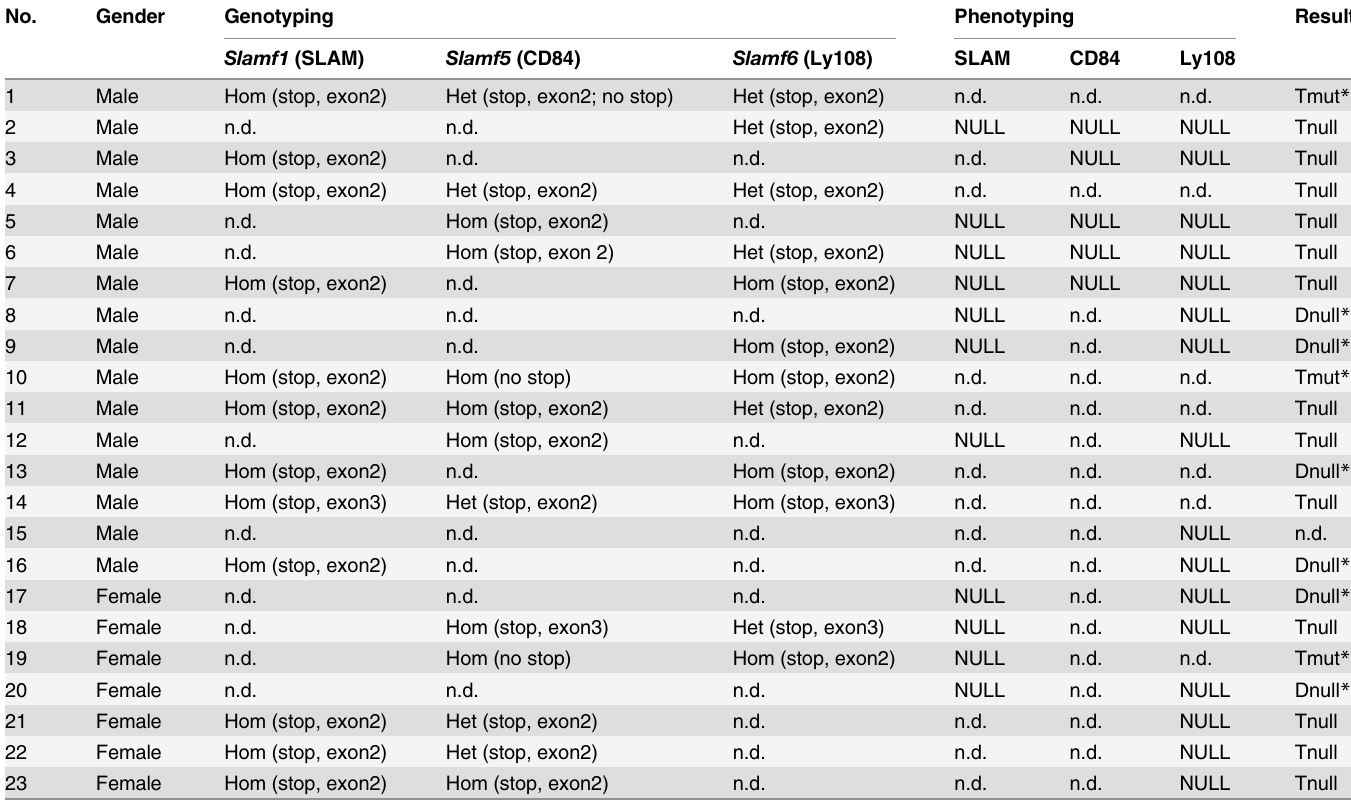
Table of mouse genotyping and phenotyping showing a high ef fi ciency of genetic mutation resulting in mice de fi cient in the expression of multiple SLAM family receptors. Hom, homozygous mutation; Het, heterozygous mutation; Stop, stop codon (TAA, TAG, or TGA) induced by gene editing; n.d., not determined; Tnull, triple gene mutations inducing null expression; Tmut * , triple gene mutations that did not result in null expression; Dnull * , double gene mutations inducing null expression, editing of third gene not determined; NULL, null protein expression as determined by surface stain.